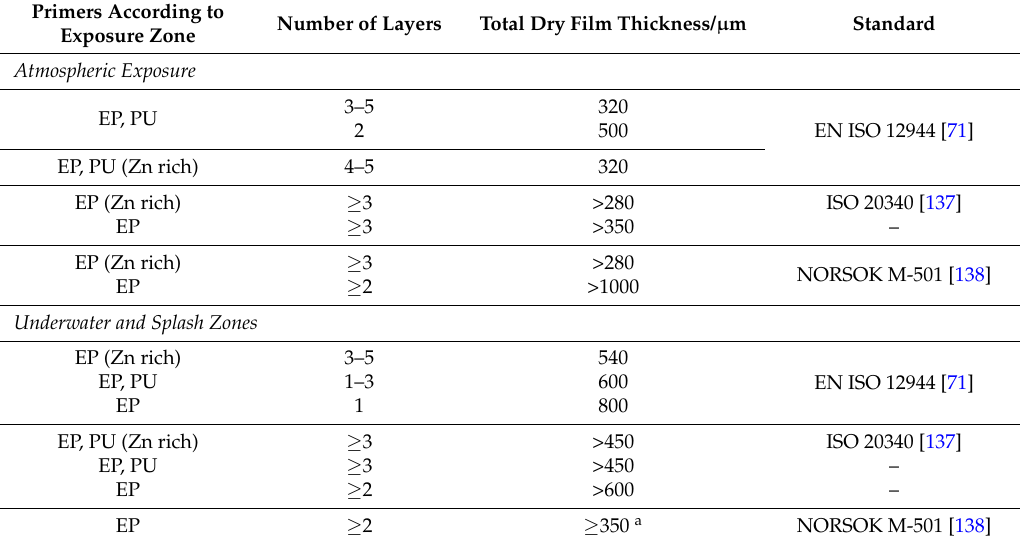
Table 6. Number of layers, total dry film thickness and type of primer used according to each standard and to exposure of OWSs.